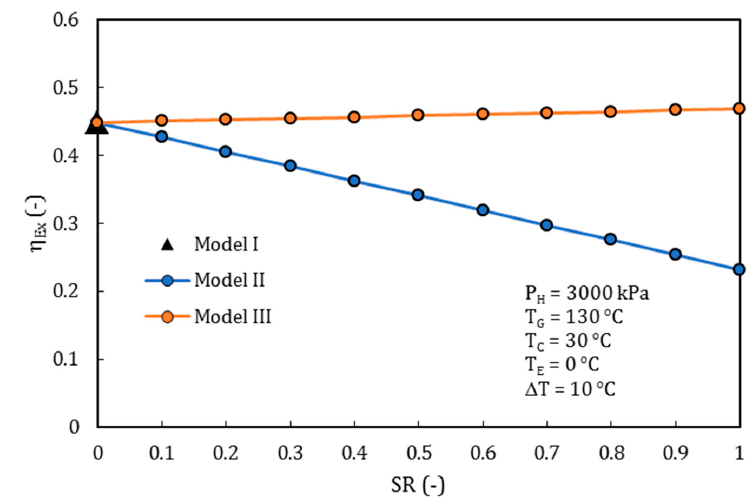
Figure 17. Comparison of the η (cid:2889)(cid:2908) as a function of SR for the three models.